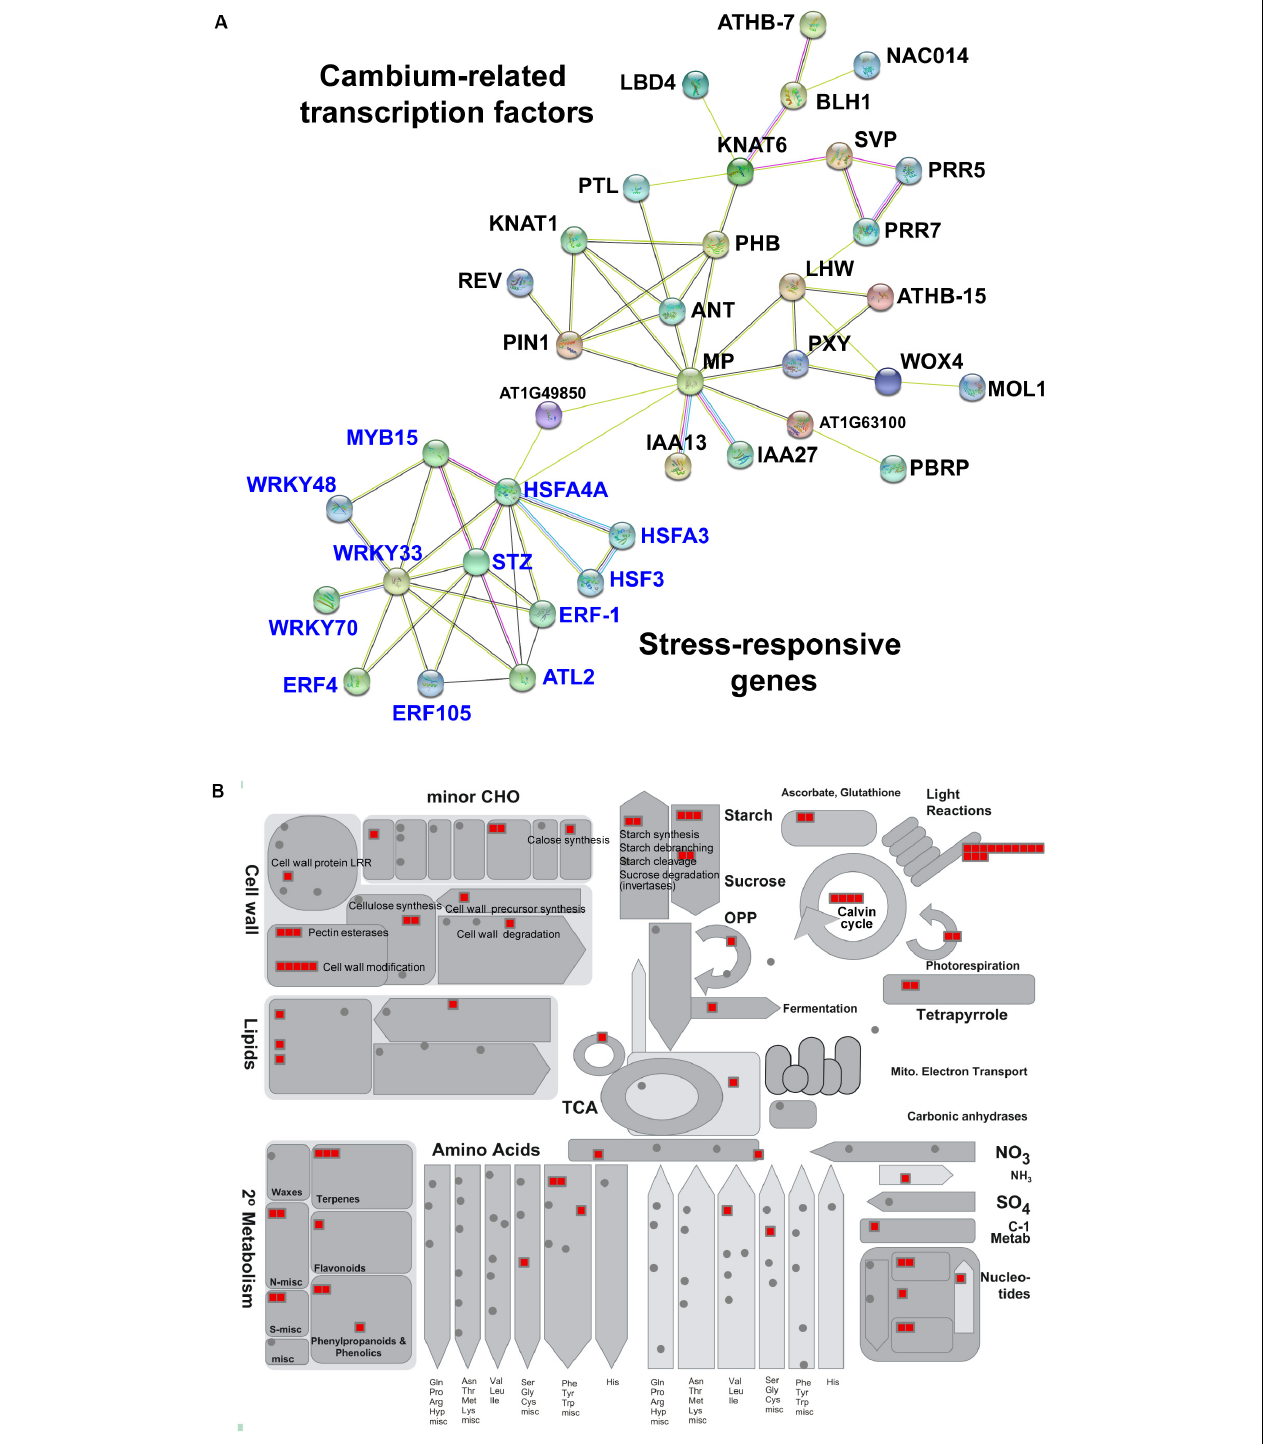
FIGURE 4 | Sub-networks of cambium-related transcription factors, stress-responsive genes and genes involved in carbon partitioning in the 403 common DEGs among major root crops. (A) Sub-networks of 65 common transcription factors that belong to two clusters corresponding to cambium regulators and stress-responsive genes. Network was visualized by the STRING database version 11.0 (Szklarczyk et al., 2015). Genes (nodes) are connected by edges, based on a default setting of evidence. The unconnected nodes were hidden in the network. (B) Common genes involved in carbon partitioning analyzed by metabolism overview tool in the MapMan software version 3.5.1 (19.11.2010) (Thimm et al., 2004) and Arabidopsis TAIR Release 10 dataset. Each red block represents one gene. CHO, carbohydrate.